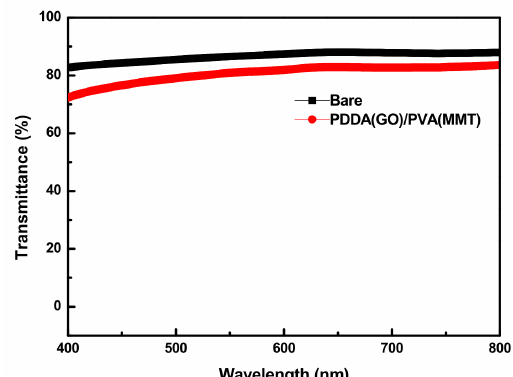
Figure 9. Light transmittance of the bare Ecoflex/PDMS substrate and 30 laminated PDDA (GO)/PVA (MMT) layers on the Ecoflex/PDMS